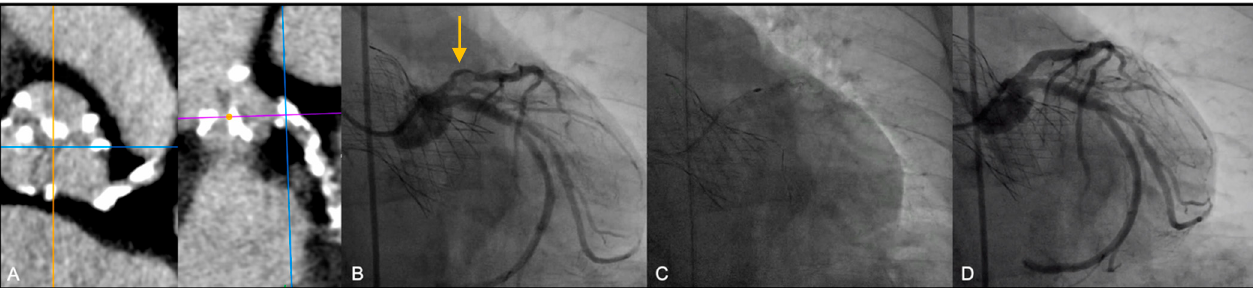
Figure 1. Rotational atherectomy (RA) following Medtronic CoreValve deployment by Trans-Femoral approach. ( A ) Pre-TAVI CT views showing severe calcification of LAD; ( B ) Pre RA angiographic evaluation of the lesion: proximal LAD presented severe calcified lesion (arrow); ( C ) Multiple burr (RotaPro 1.25 mm) advancements; ( D ) Final result, after stent deployment and post dilation.